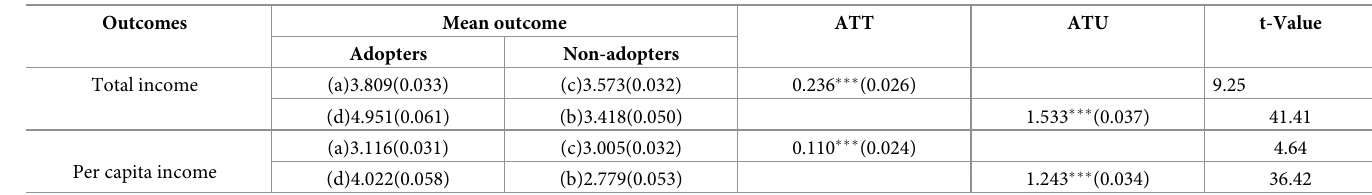
Table 7. Average treatment effect of the impact of new technology adoptation on family farms’ operating income.